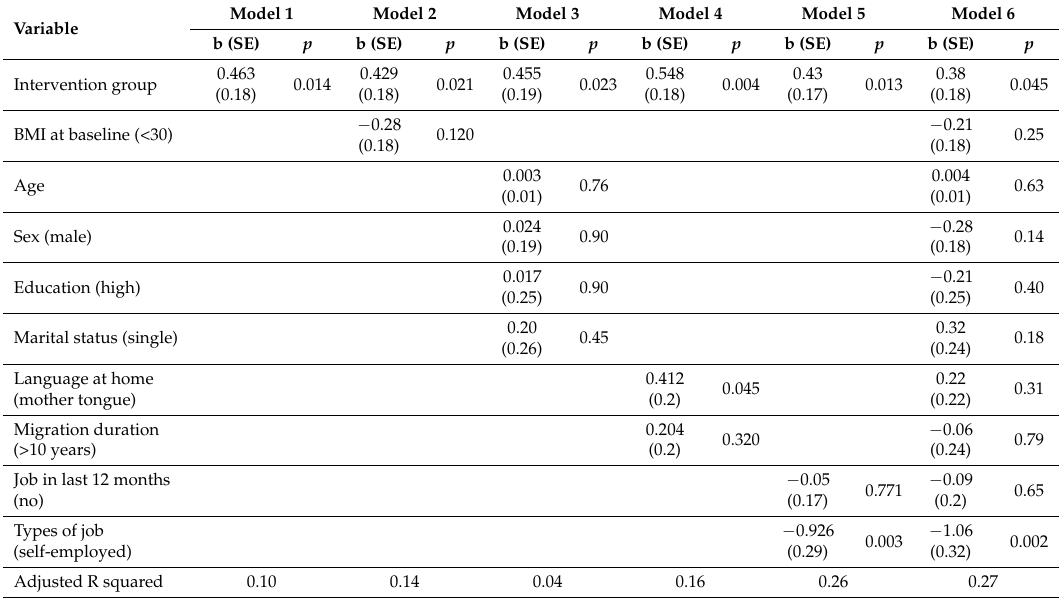
Table 4. Linear regression for positive willingness-to-pay values (natural logarithms) .